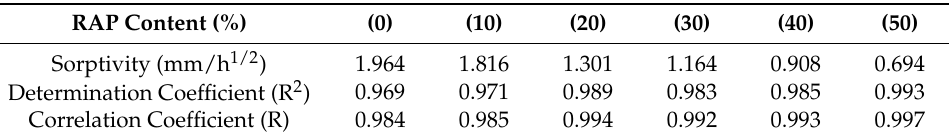
Table 11. Sorptivity by RAP inclusive concrete.